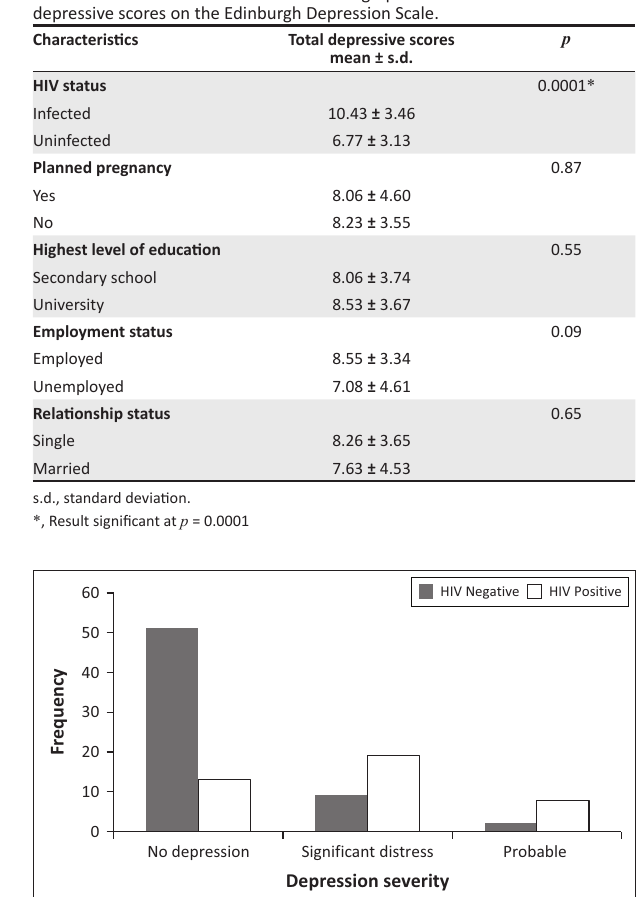
Table 2. Evaluation of the EDS demonstrated a Cronbach’s alpha of 0.76.